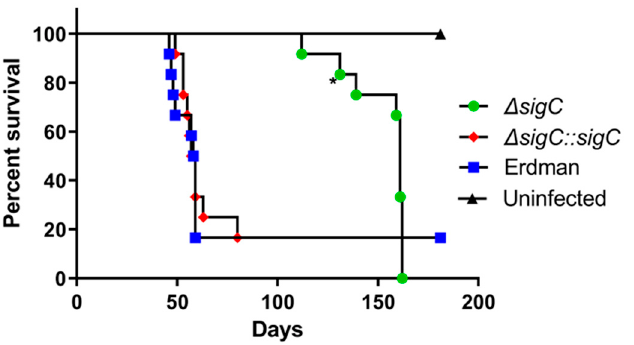
Figure 7. Survival of SCID mice infected with M. tuberculosis strains. Groups of 12 SCID mice were infected by intratracheal instillation with 0.025 mL of 10 4 CFU/mL of strain Erdman, Δ sigC , or Δ sigC::sigC , or instilled with an equal volume of PBS. Animal survival differences between the sigC mutant and either the parent or complement group was analyzed by the Mantel–Cox test (* p < 0.05).